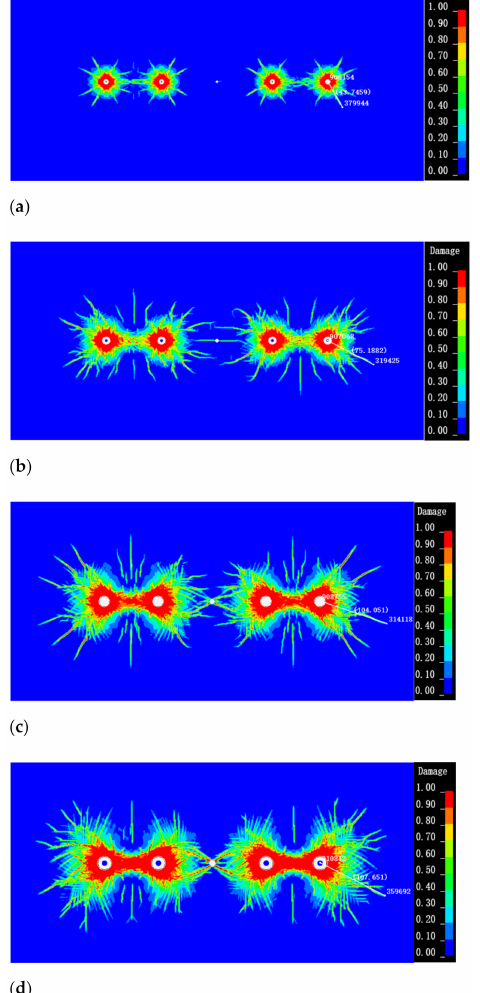
Figure 7. Evolution and distribution characteristics of cracks between blasting roof cutting holes with different hole diameters. ( a ) Blasting hole diameter 30 mm. ( b ) Blasting hole diameter 50 mm. ( c ) Blasting hole diameter 70 mm. ( d ) Blasting hole diameter 90